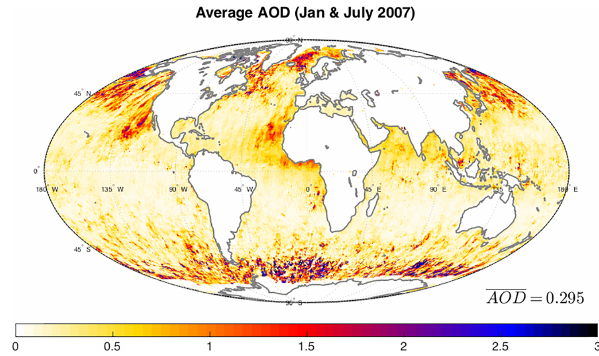
Figure 2. Average AOD obtained using unscreened data from Jan- uary and July of 2007. The data are mapped to a 0 . 5 ◦ × 0 . 5 ◦ grid. High AOD values over remote oceans indicate issues with cloud contamination in the retrieval